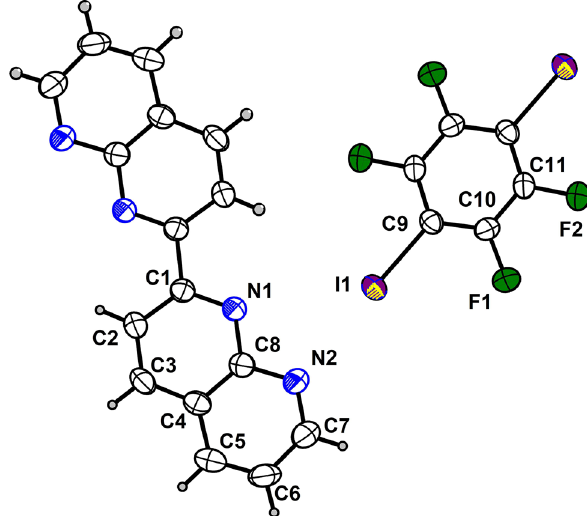
Table 1 contains crystallographic data and Table 2 contains the list of the atoms including atomic coordinates and displacement parameters.